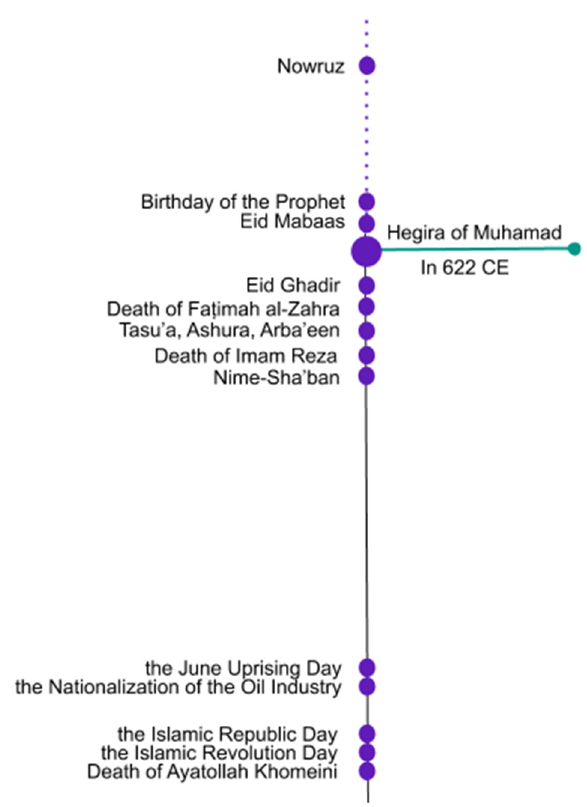
Figure 2. The Islamic Republic’s National Commemogram.